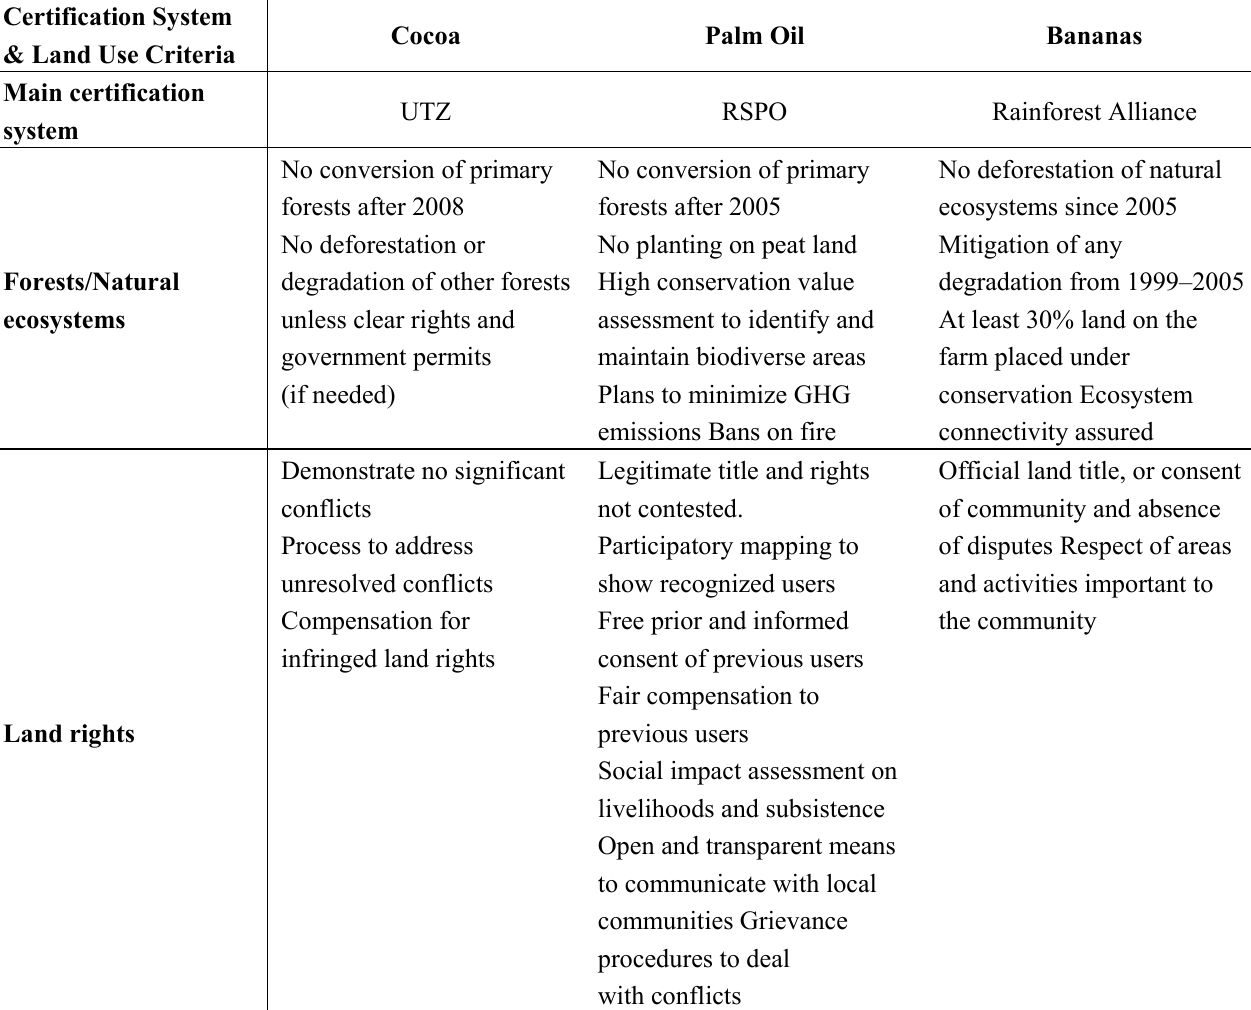
Table 4. Comparison of certification of criteria for land use changes for the most important certifying schemes for cocoa, palm oil and